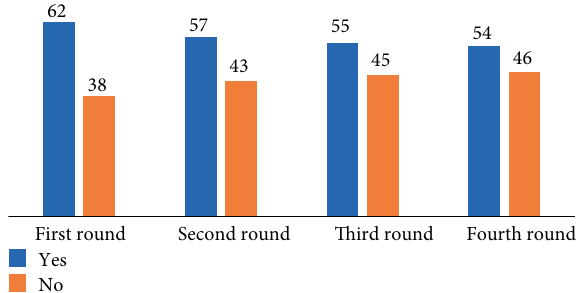
Figure 4: Health seeking behaviour for current medical condition of the study participants ( 𝑛 = 260 ). Advice to return, if no improvement, % ( 𝑛 =